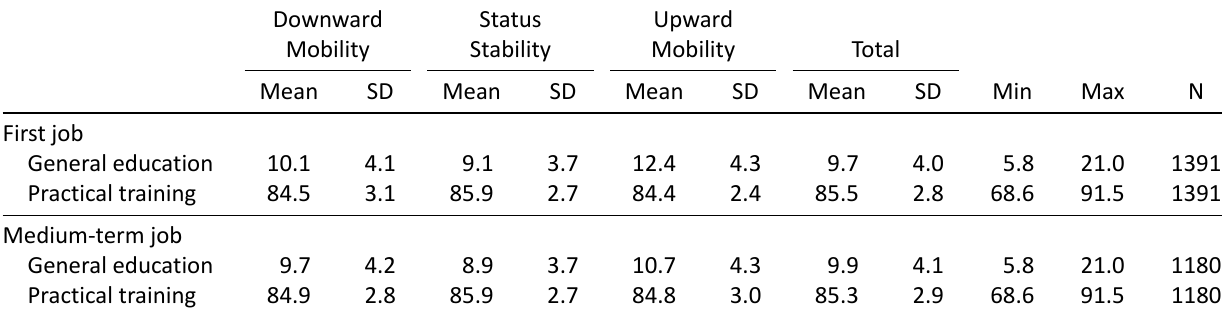
Table 2. Distribution of the proportion of general education and practical training by status mobility (in